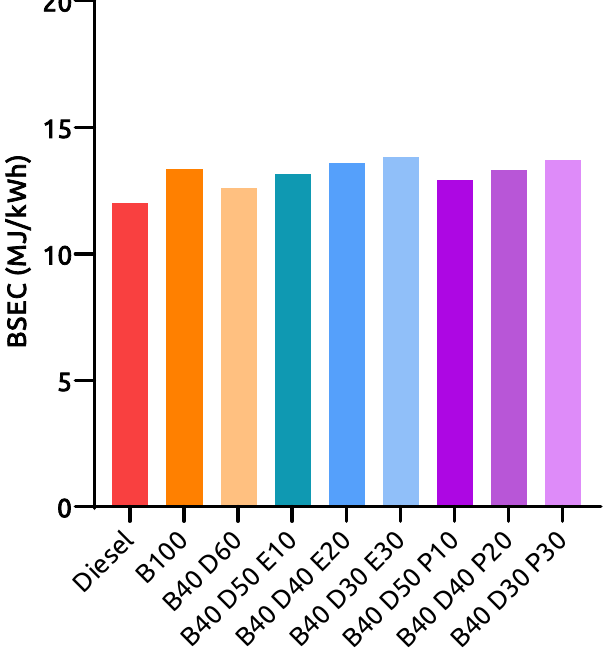
Figure 4. Brake specific energy consumption for tested fuels at full engine load.